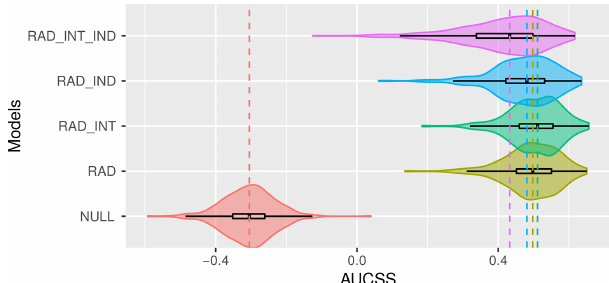
Figure 1. Distribution of the cross-validated area under receiver operating characteristic curve skill score (AUCSS) of 401 admin- istrative districts is shown for different logistic regression models for weather-related accident probabilities. The probability density is smoothed by a kernel density estimator (shading). The median is indicated by vertical dashed